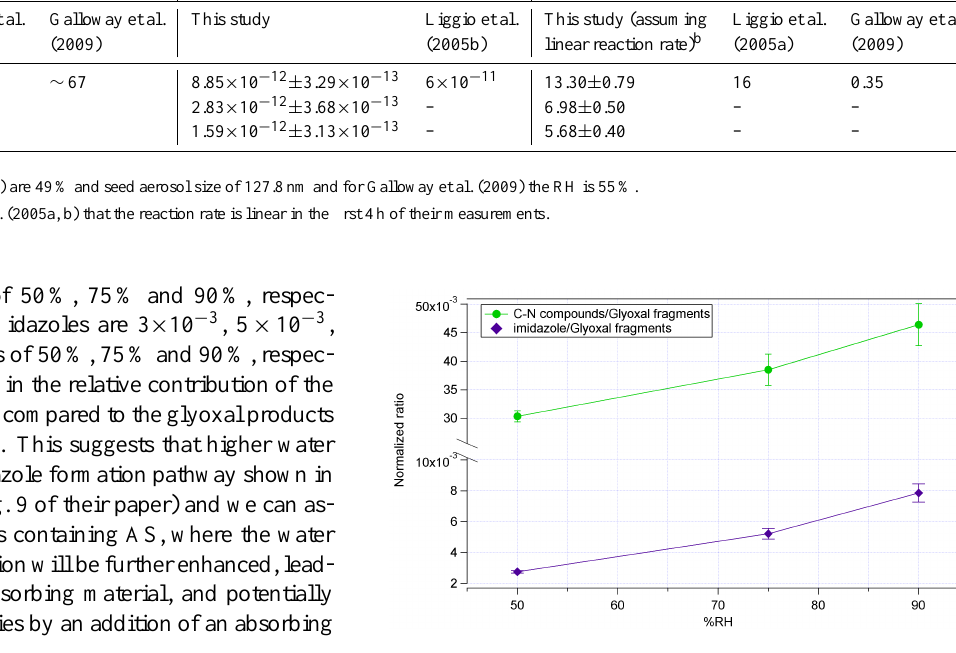
Table 3. Comparison to literature values of the mass growth rate and the ratio of final mass to seed mass (normalized by sulfate mass) assuming linear reaction rate, from AMS data, after 4h of reaction of AS 300nm with glyoxal gas. Glyoxal gas concentration (ppb) This study Liggio et al. This study (assuming Liggio et al.